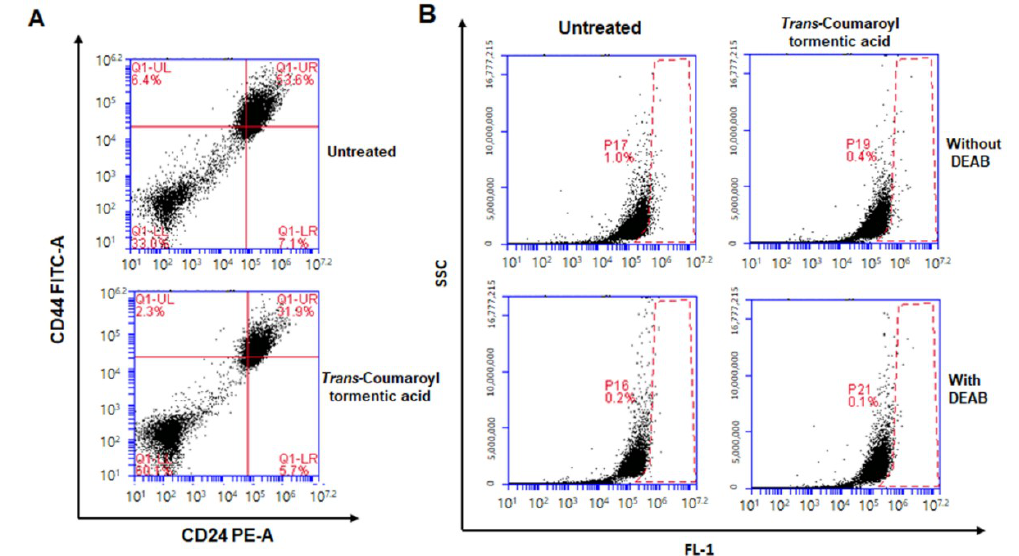
Figure 4. Effect of 3 - O - trans - p -coumaroyltormentic acid on the expression of CSC markers in breast cancer cell line. ( A ) The CD44 high /CD24 low cell population was analyzed by flow cytometry in MDA-MB-231 cells treated with either 3 - O - trans - p -coumaroyltormentic acid (20 μM) or DMSO for two days. For FACS (Flow Cytometer) analysis, 50,000 cells were acquired. Gating was based on binding of the control antibody (red cross). ( B ) The effect of 3 - O - trans - p -coumaroyltormentic acid on the ALDH-positive cell population. MDA-MB-231 cells were treated with either 3 - O - trans - p -coumaroyltormentic acid (20 μM) or DMSO for two days and subjected to the ALDEFLUOR assay and FACS analysis. A set of representative flow cytometer dot plots is shown. The lower panel shows ALDH-positive cells in the presence of the ALDH inhibitor diethylaminobenzaldehyde (DEAB) as a negative control, and the upper panel represents ALDH-positive cells in the absence of DEAB. The ALDH-positive population was gated in the box (red dot line box).